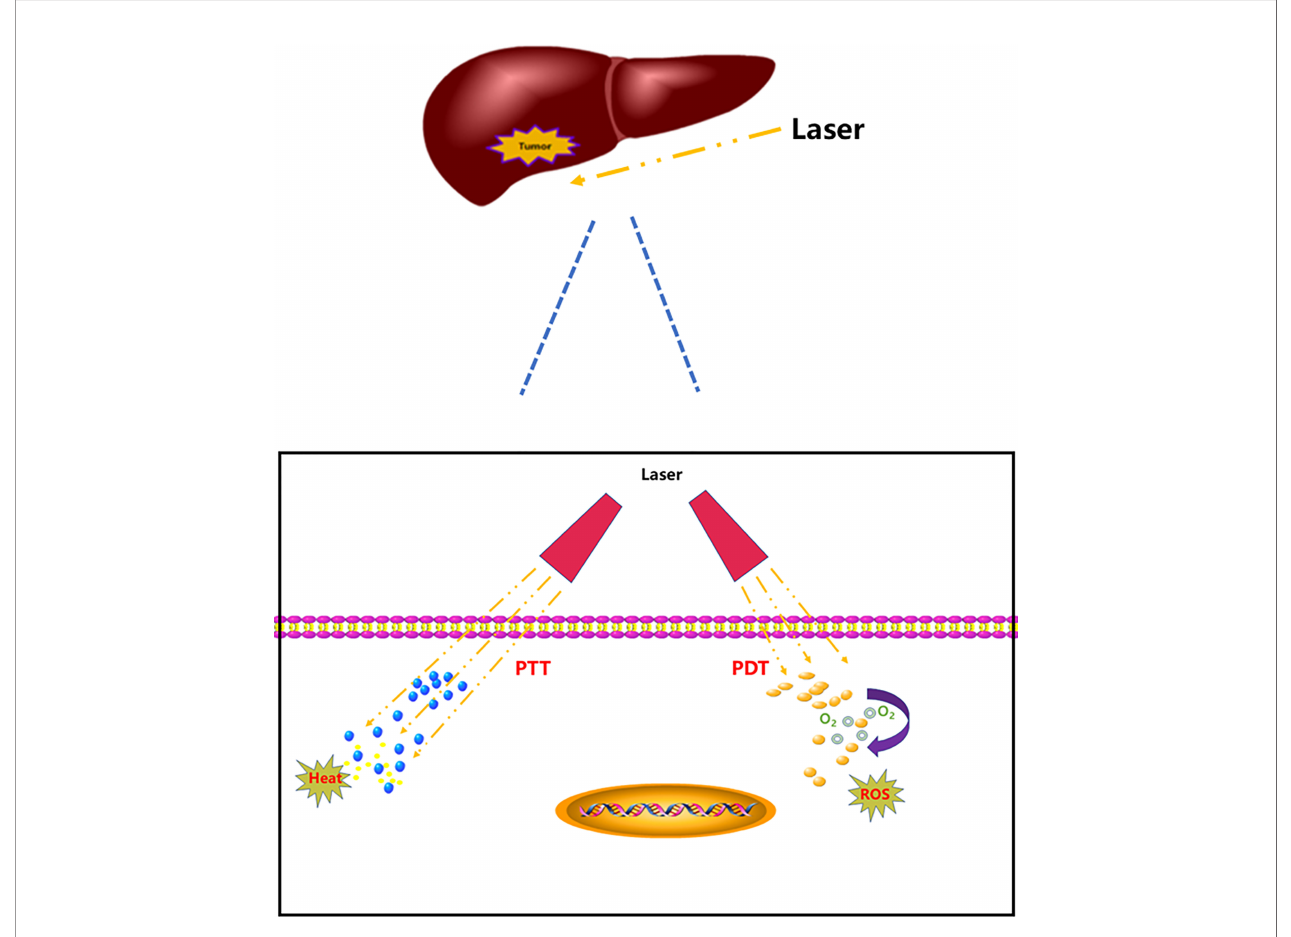
FIGURE 1 | PTT and PDT for